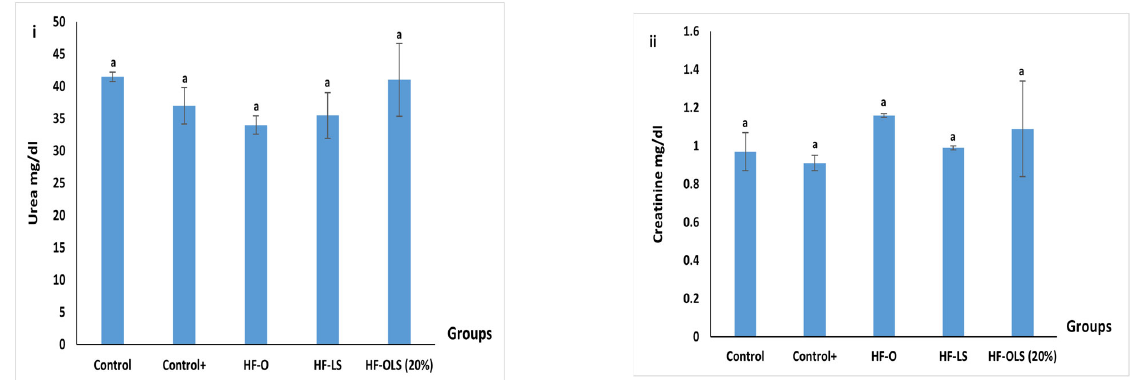
Figure 8. Kidney functions: ( i ) urea (mg/dl) and ( ii ) creatinine (mg/dl) of rats fed with standard diet, high fat diet, and high fat diet and juice for three months. Control (rats fed with a standard diet), Control+ (rats fed with a high ‐ fat diet composed by mixing a standard diet with 20% of vegetarian ghee), HF ‐ O (rats fed with a high ‐ fat diet and 9 mL/kg/day of orange juice), HF ‐ LS (rats fed with a high ‐ fat diet and 9 mL/kg/day of beetroot leaf–stem juice), HF ‐ OLS (20%) (rats fed with a high ‐ fat diet and 9 mL/kg/day of orange juice mixed with 20% of beetroot leaf–stem juice). Columns labeled with different letters are significantly different at p < 0.05.